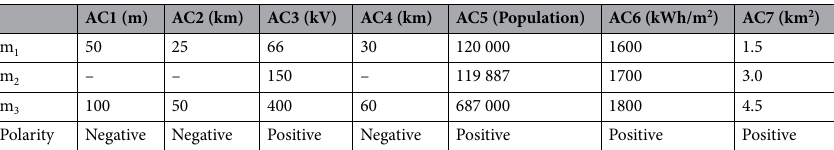
Table 7. Triangular fuzzy numbers for criteria AC1 ÷ AC7.